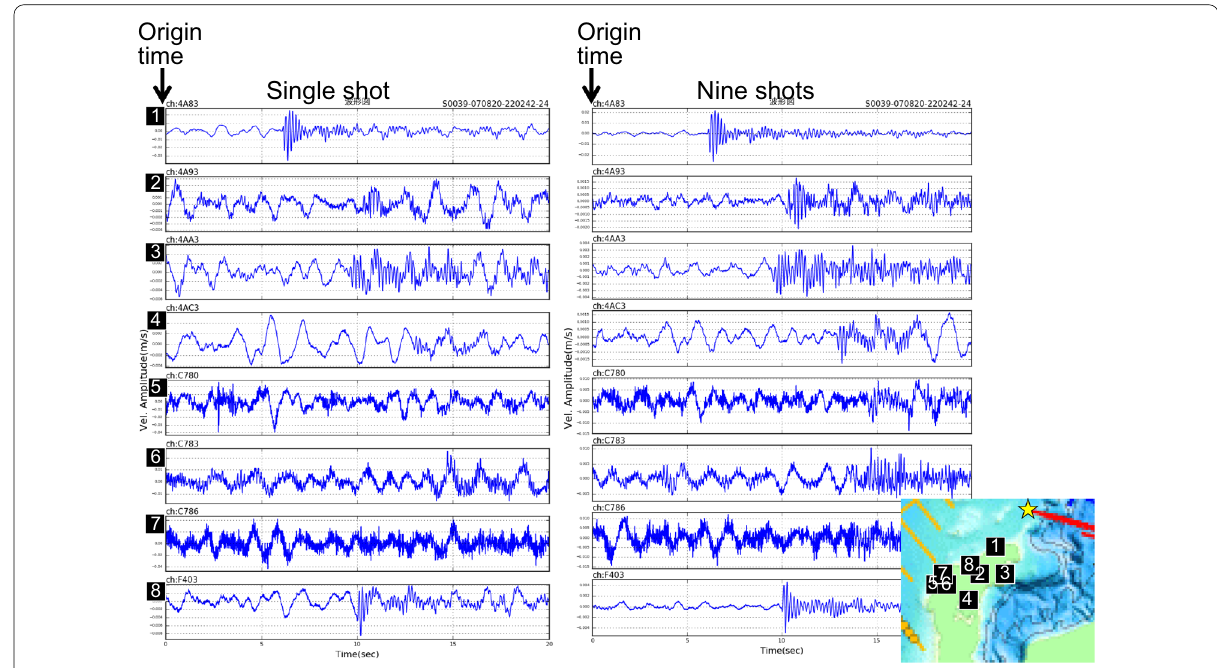
Fig. 3 Waveforms of the single shot (left) and stacked waveform of nine consecutive shots (right)